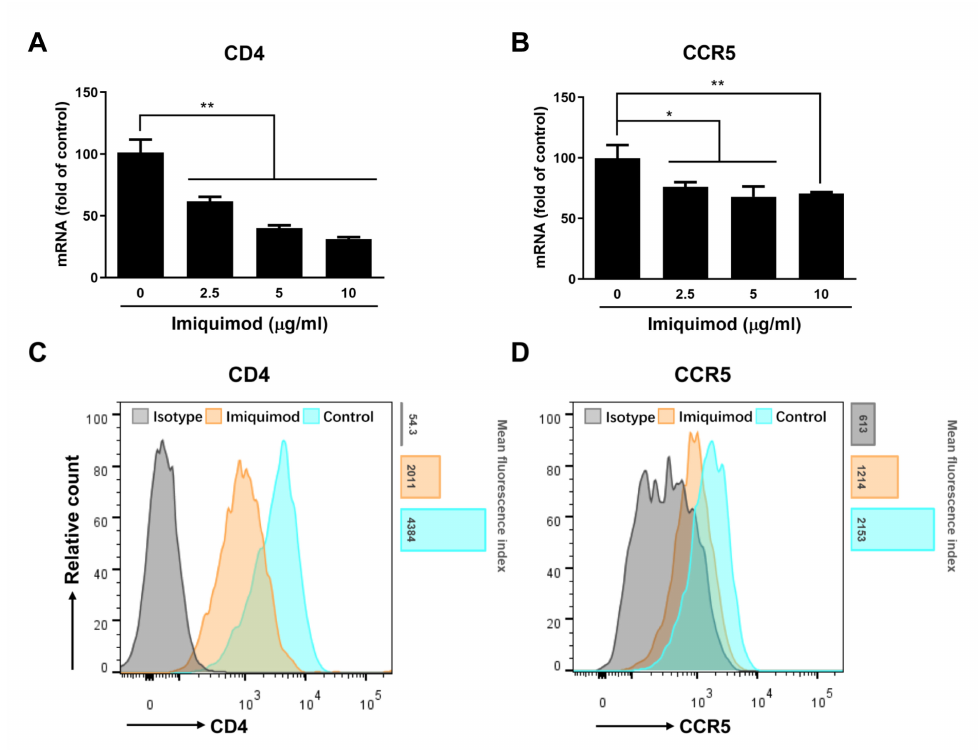
Figure 7. Effect of imiquimod on CD4 and CCR5. ( A , B ) Macrophages were treated with imiquimod at the indicated concentrations for 12 h. Cellular RNAs were collected and subjected to real-time PCR for CD4 and CCR5 mRNA expression. ( C , D ) Macrophages were treated with imiquimod (10 µ g/mL) for 24 h and then collected for the flow cytometry analysis of CD4 and CCR5 protein expression. Data are shown in A and B as mean ± SD of three independent experiments (* p < 0.05, ** p < 0.01). Flow cytometry data shown in C and D are the representative pictures of two independent